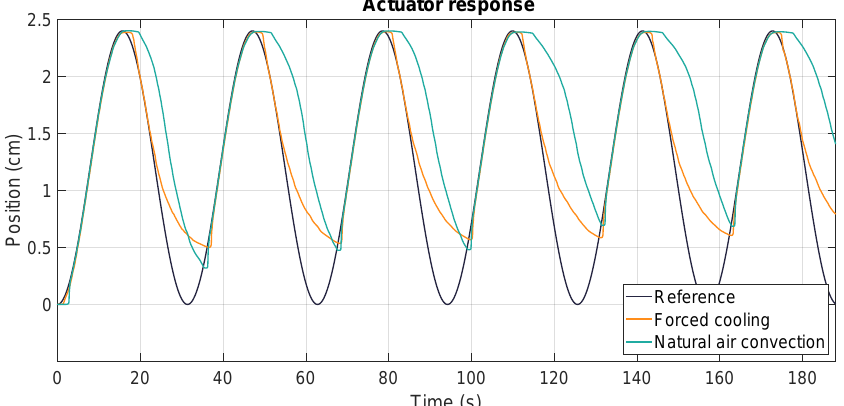
Figure 12. Comparison of natural and forced cooling for a frequency of 0.2 rad/s and a load of 2.00